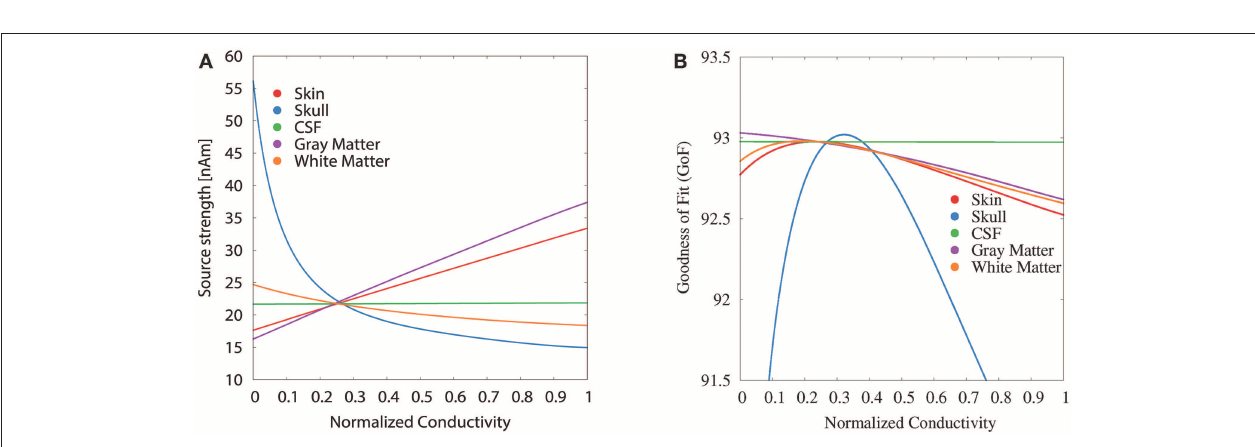
FIGURE 5 | Scatter plots of source strength (A) and GoF (B) for GFS with fixed dipole location and orientation as a function of the tissue conductivity for univariate distributions. Dipole location and orientation are chosen according to the initial dipole reconstruction (see section 2.3). Conductivities are normalized to the interval from 0 to 1 for clarity of the